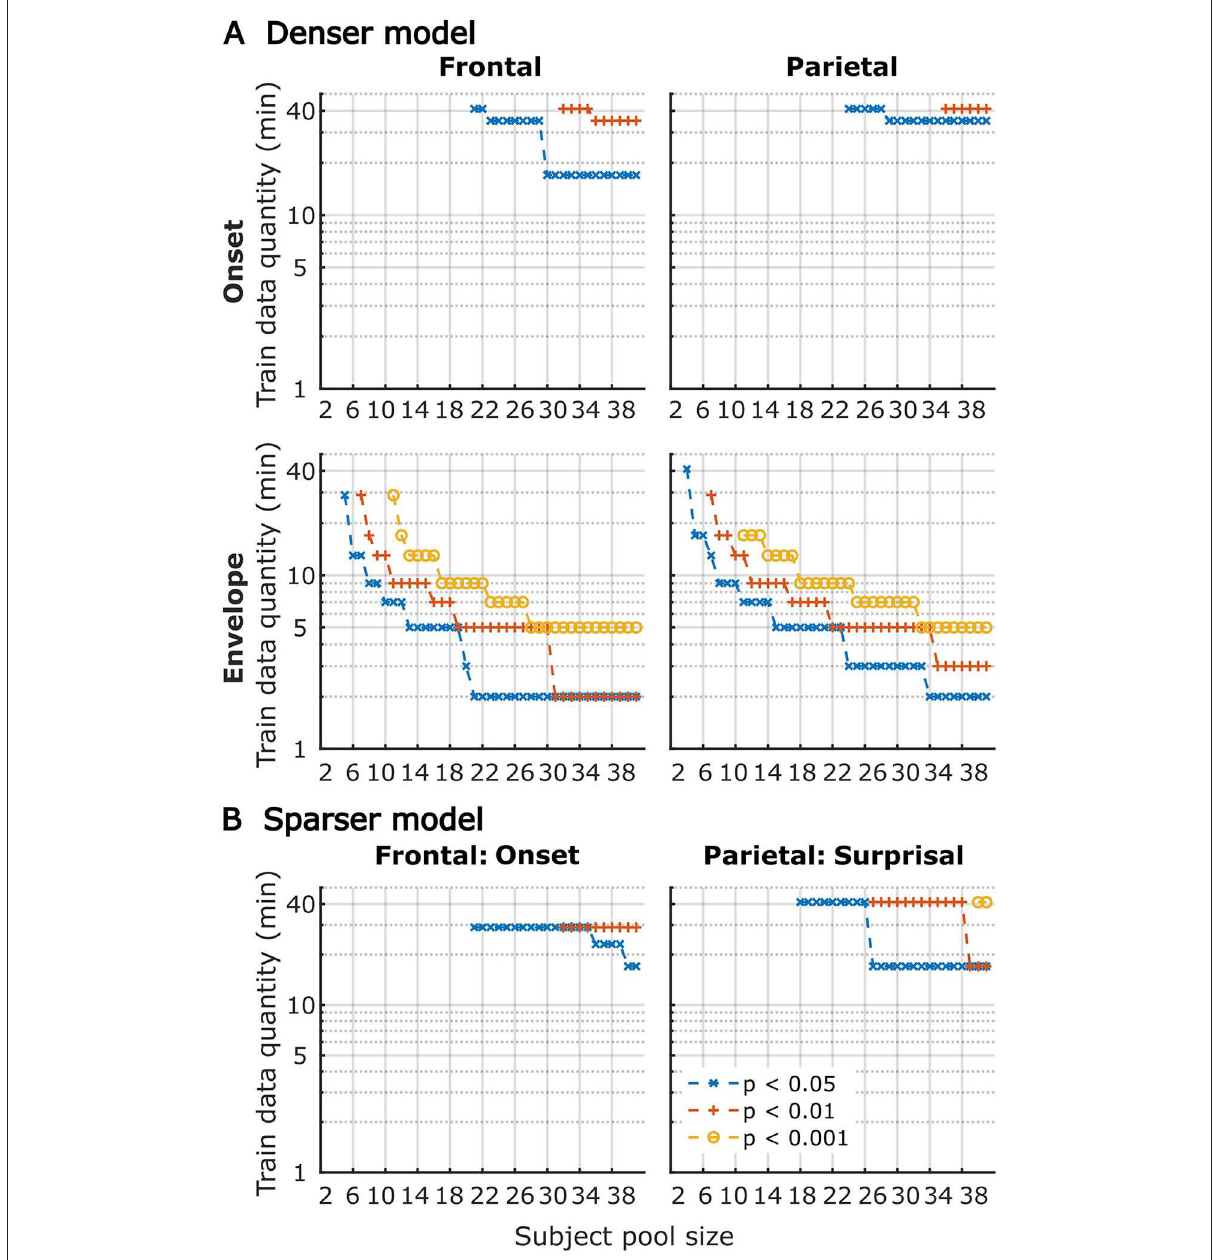
FIGURE8 Amount of training data per participant required to reach significant feature-specific contributions to model prediction accuracies, as a function of participant sample size for the denser (A) and sparser (B) TRF models in frontal (left column) and parietal (right column) ROIs. Note that for the sparser model, only feature-ROI combinations where significant feature-specific model contributions could be achieved are shown (except for surprisal in the frontal ROI, where p < 0.05 could be achieved with 40 + participants at 17 + min of data). Line colors represent different significance levels (see legend in lower